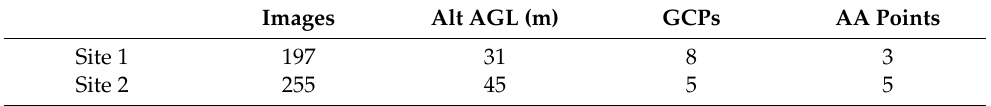
Table 1. AltAGL=Altitudeabovegroundlevel, GCP=Groundcontrolpoints, AA=Accuracyassessment. Images Alt AGL (m) GCPs AA Points Site 1 197 31 8 3 Site 2 255 45 5